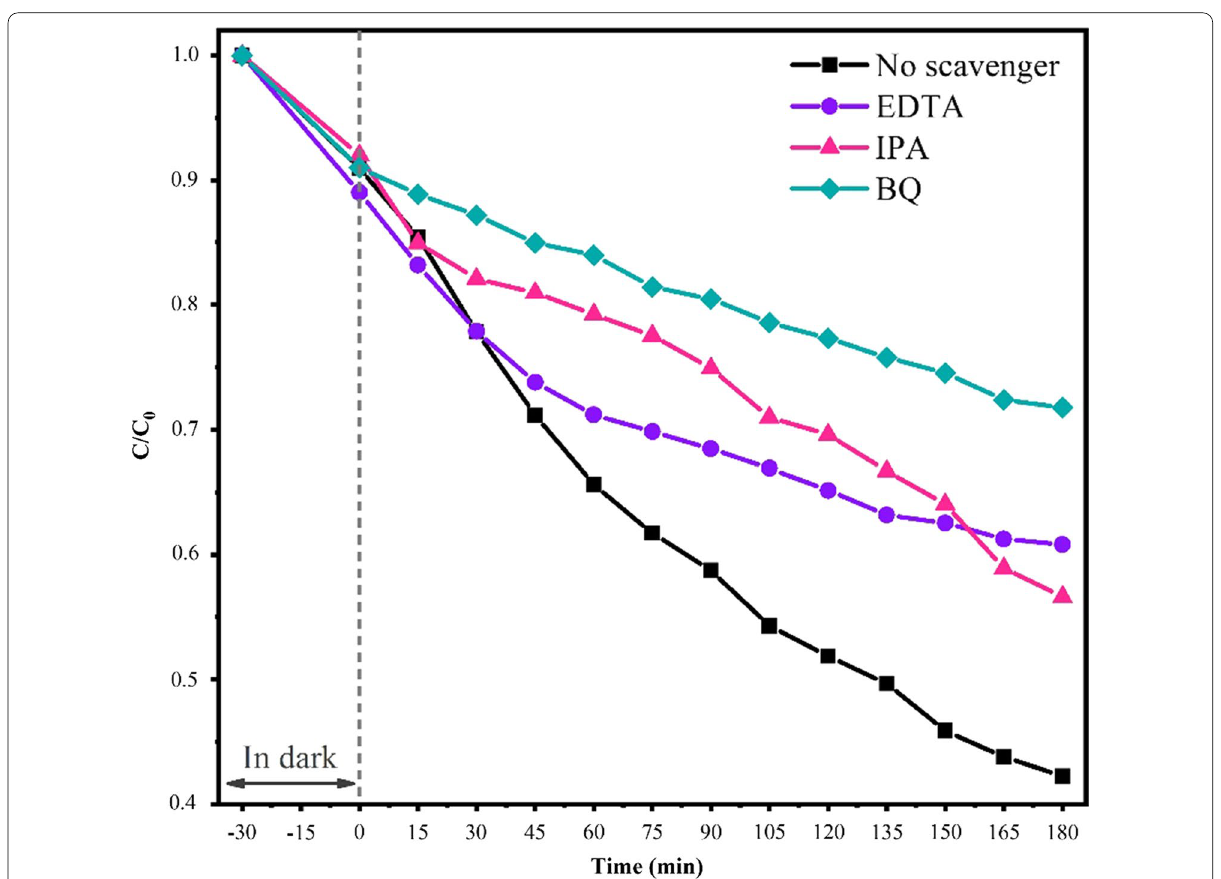
Fig. 9 Degradation curves of MeO with different scavengers under the visible light by Bi 2 O 3 /Bi 2 O 2 CO 3 /(BiO) 4 CO 3 (OH) 2